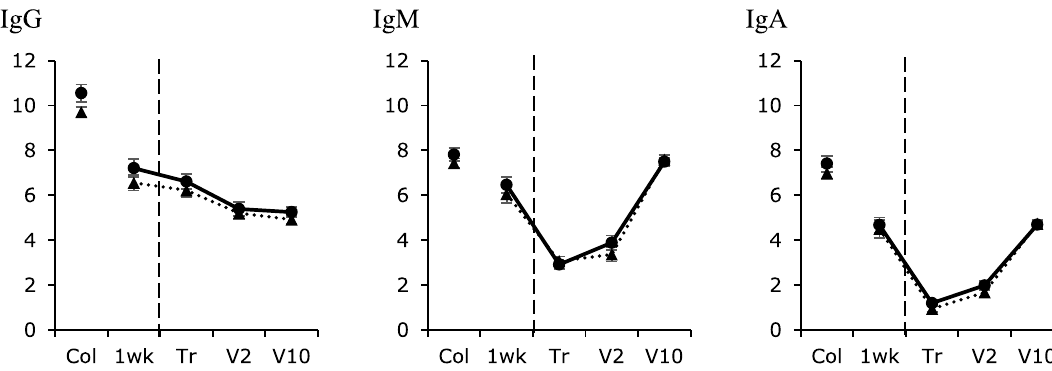
Figure 3. Immunoglobulin G, M and A titers (mean ± SEM) across rearing treatments (without dam = dotted line; with dam = continuous line). Levels are given across 5 collection time points based on analysis of dam colostrum and calf blood serum: Col = colostrum; 1 wk = at 1 week of age; Trp = the day prior to transport; V2 = after 2 weeks at the veal farm; V10 = after 10 weeks at the veal farm. The vertical dashed line indicates the start of the transport treatment. No differences between the rearing treatments were identified (P >